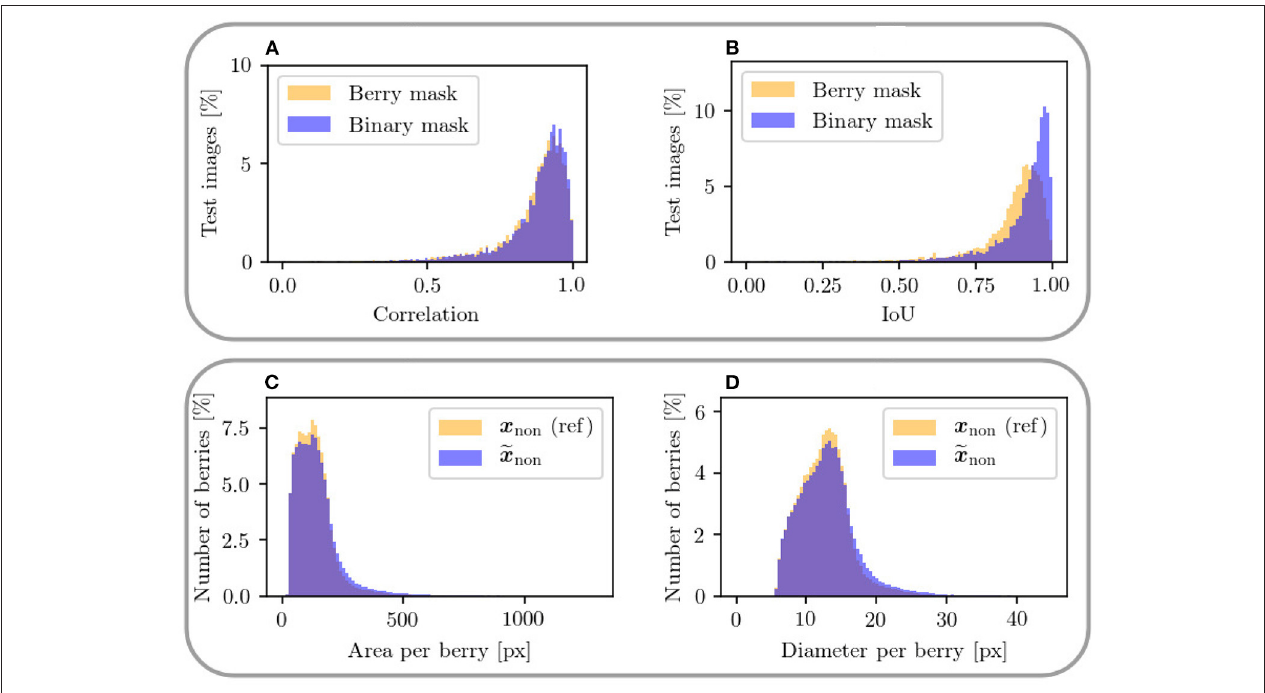
FIGURE 12 | The upper plots show a mask-based comparison within the non-occluded domain between berry mask and binary mask including only two classes for the metrics (A) correlation between x non and berry between target output x non and generated output